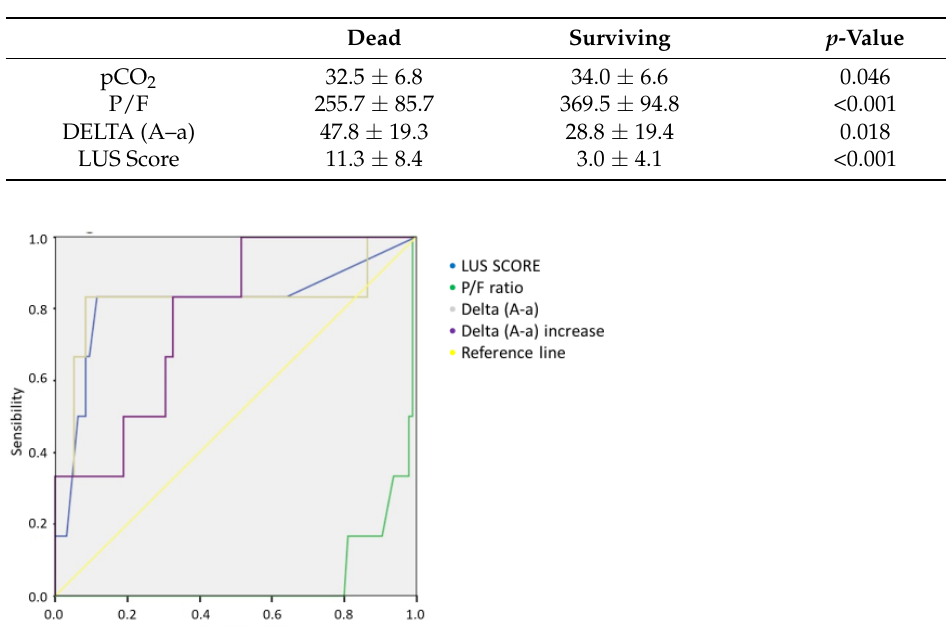
Figure 5. Correlation between LUS score and delta (A-a) increase in COVID-19 patients. The data show a statistically significant direct correlation. Table 4. Comparison of blood gas analysis and ultrasound data between dead and surviving COVID- 19 patients.